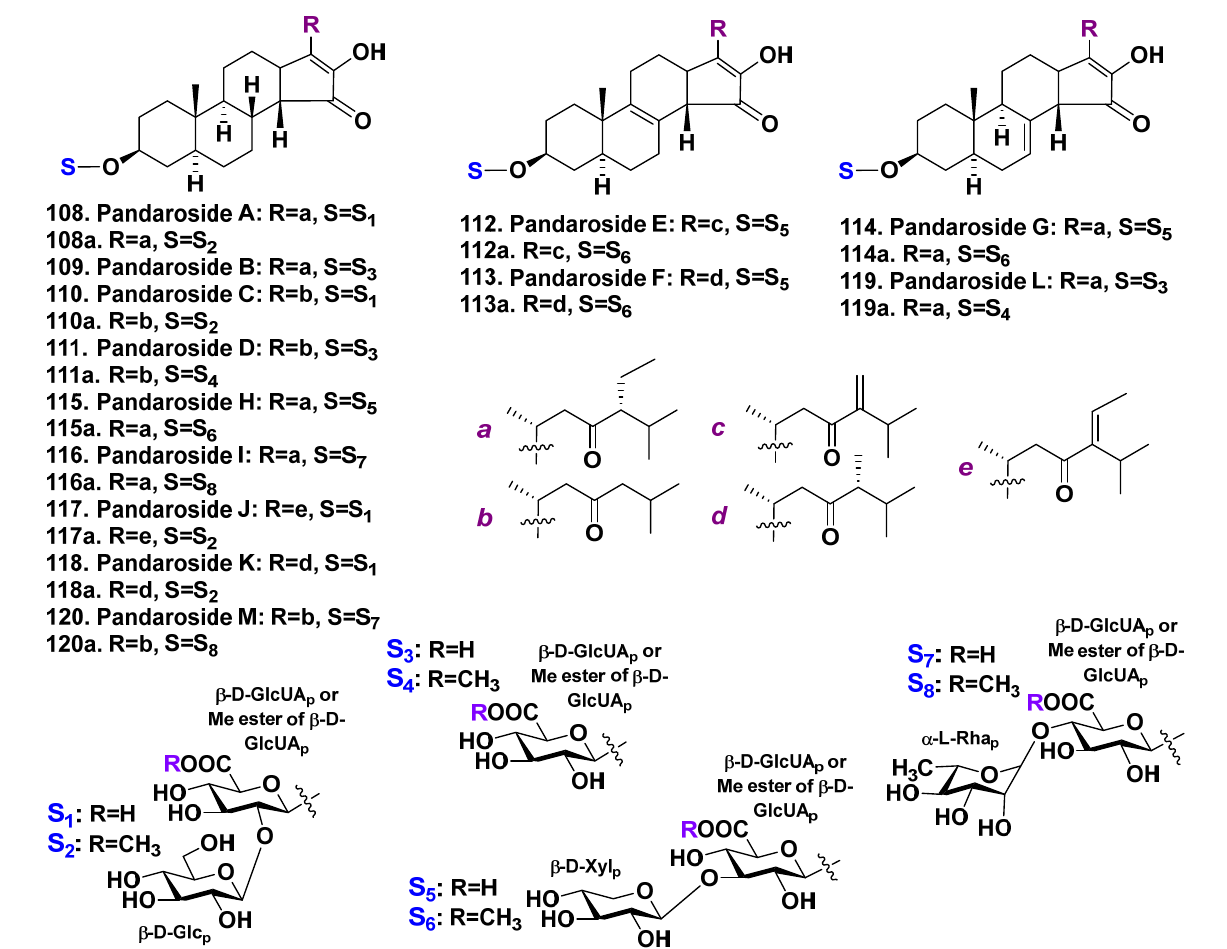
Figure 14. Pandarosides 108 – 120 and their methyl esters 108a , 110a – 120a from Pandaros acanthifo ‐ lium